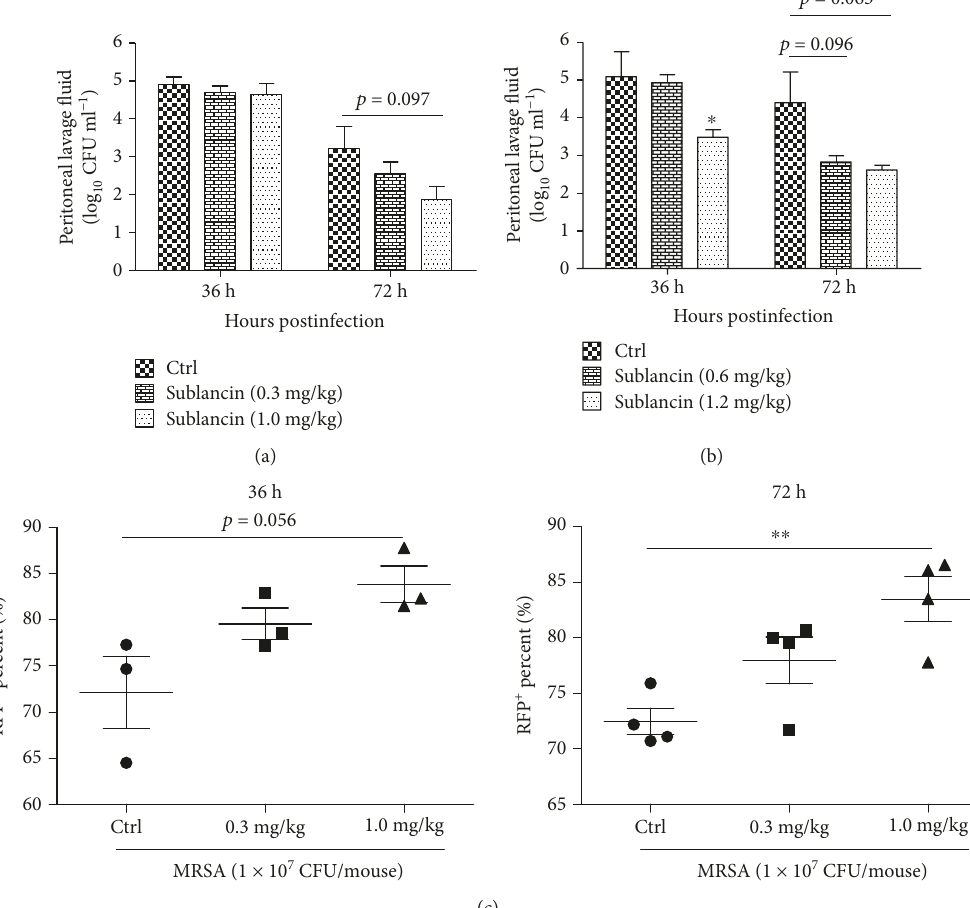
Figure 6: E ffi cacy of sublancin in the MRSA-induced sublethal infection model. (a) Mice were orally administered with sublancin at 0.3mg/kg or 1.0mg/kg once a day for 14 consecutive days before intraperitoneal inoculation of MRSA ATCC43300. The staphylococcal load in the peritoneal lavage was enumerated at 36 and 72h of infection. (b) Sublancin (0.6 mg/kg or 1.2mg/kg) was administered by gavage daily for 14 days before infection. Mice were analyzed for bacterial counts in the peritoneal lavage at 36 and 72 h of infection. (c) Peritoneal macrophages were collected 36 and 72 hours after infection for red fl uorescent protein- (RFP-) labeled Escherichia coli phagocytosis assay. Data shown are means ± SEM and derived from 3 to 4 mice in each group. Signi fi cant di ff erences with the control group were designated as ∗ P < 0 05 and ∗∗ P < 0 01